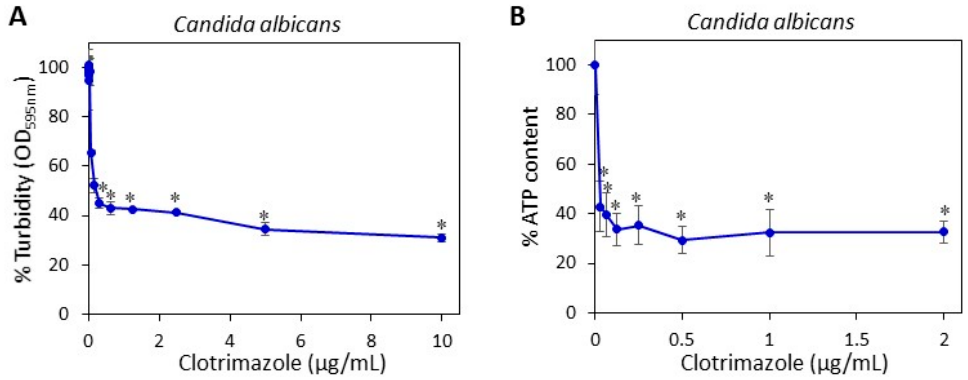
Figure 1. The antifungal effect of CTZ on C. albicans . ( A ) C. albicans at an initial OD 600 nm of 0.3 was exposed to increasing concentrations of CTZ, and the OD 595 nm after 24 h was measured in a Tecan M200 plate reader; ( B ) C. albicans at an initial OD 600 nm of 0.3 was exposed to increasing concentrations of CTZ for 24 h, and the ATP content was measured by luminescence in a Tecan M200 plate reader. * p < 0.05 versus control. N = 3.